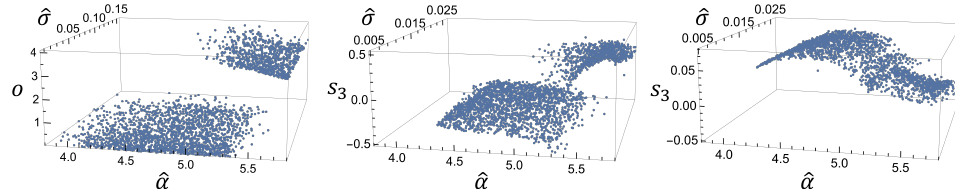
Figure 4: Prior distribution of sufficient summary statistics (10) - (12) (left), and of the latent variables from both ENCA (middle) and INCA (right). The two sheets correspond to the two attractors of the model and overlap on the ( ˆ α , ˆ σ ) -projection